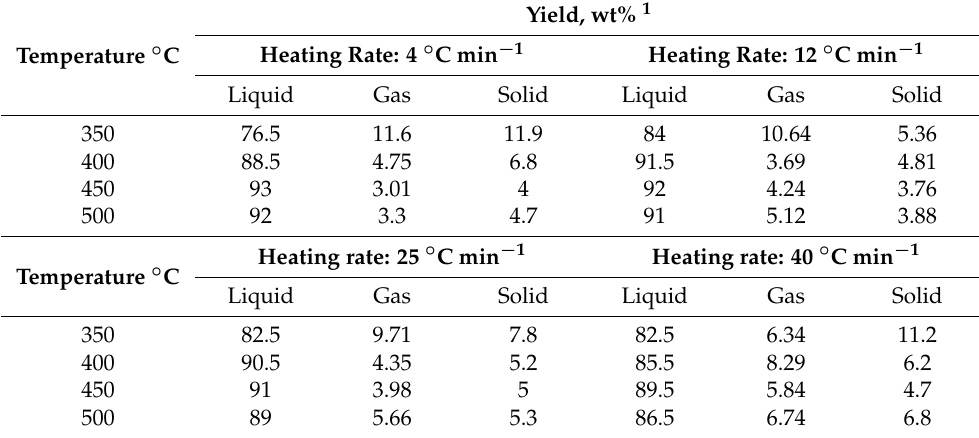
Table 2. Influence of temperature on the performance of the EPS pyrolysis